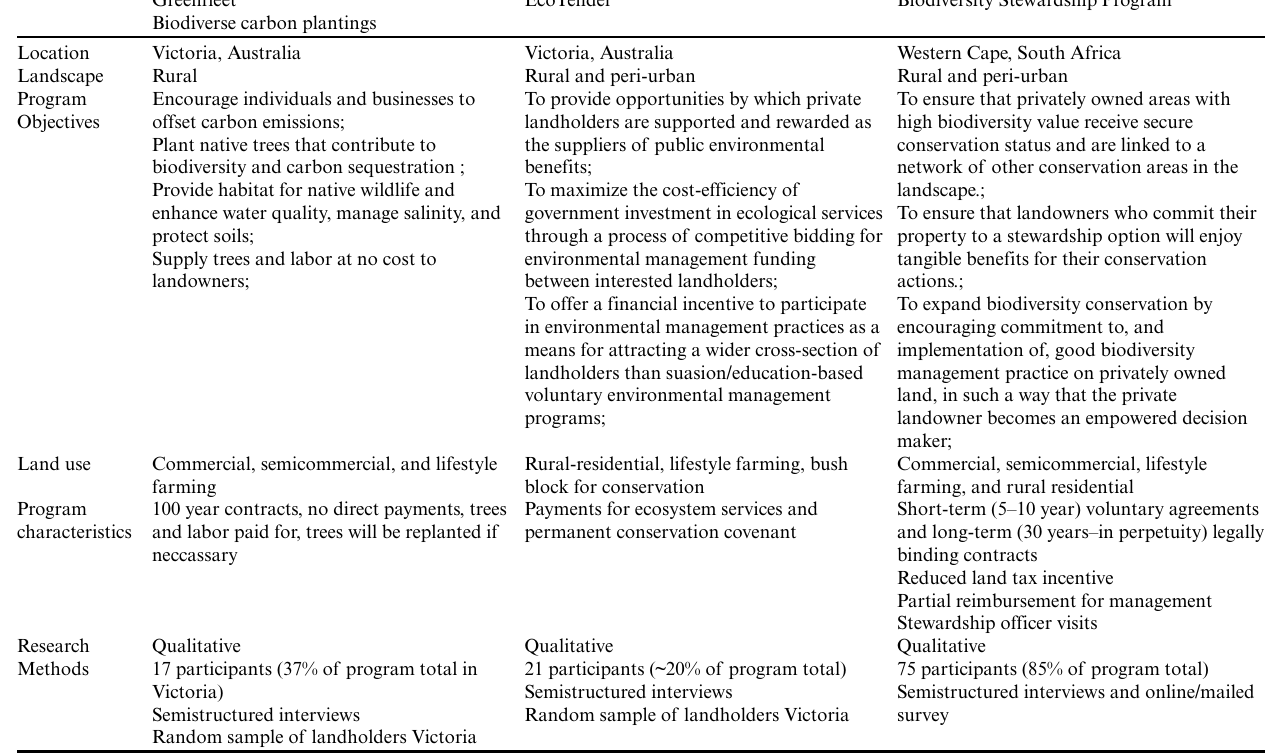
Table 1 . Program attributes and study methods. Greenfleet Biodiverse carbon